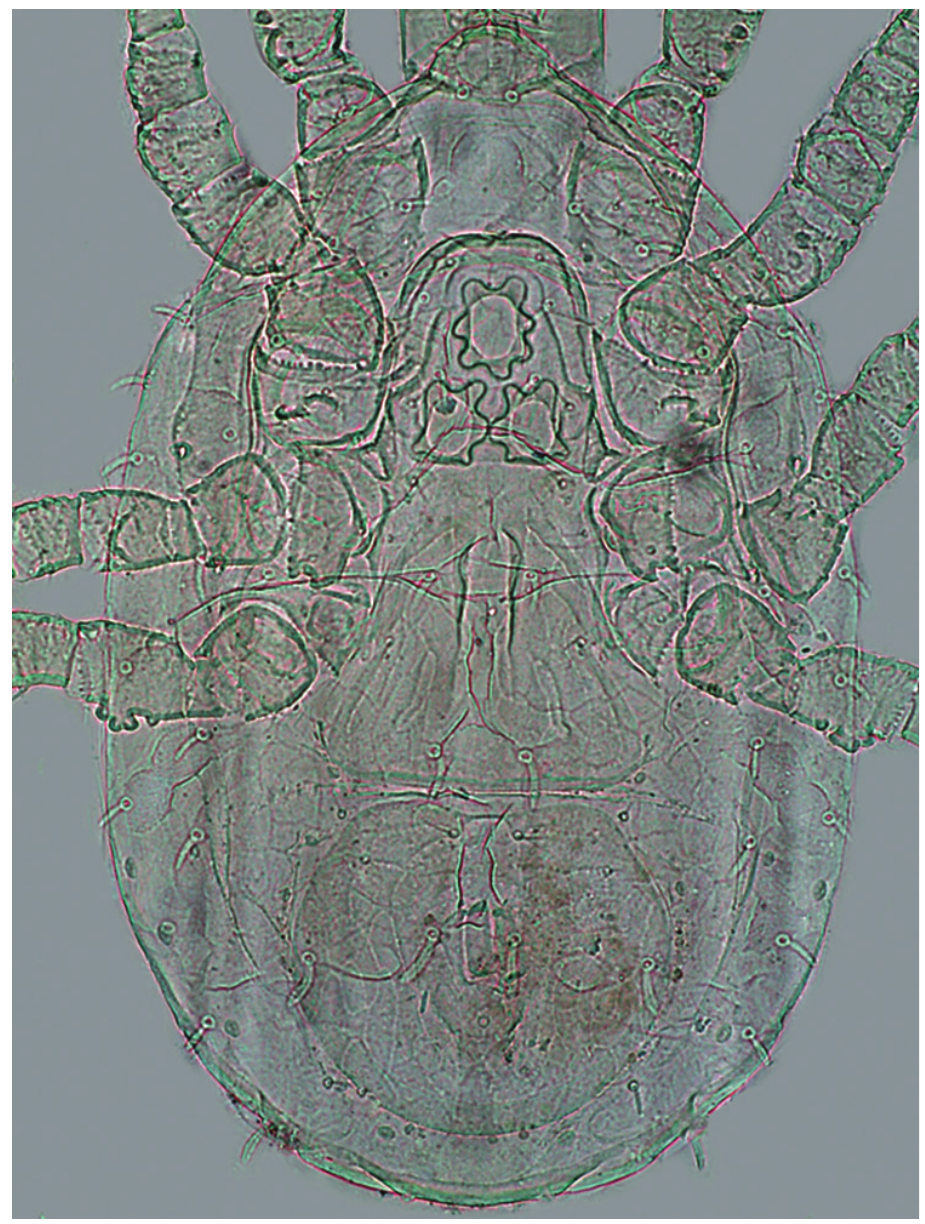
Plate 69. Sertitympanum contiguum , female (from U.S.A.), idiosoma (pressed